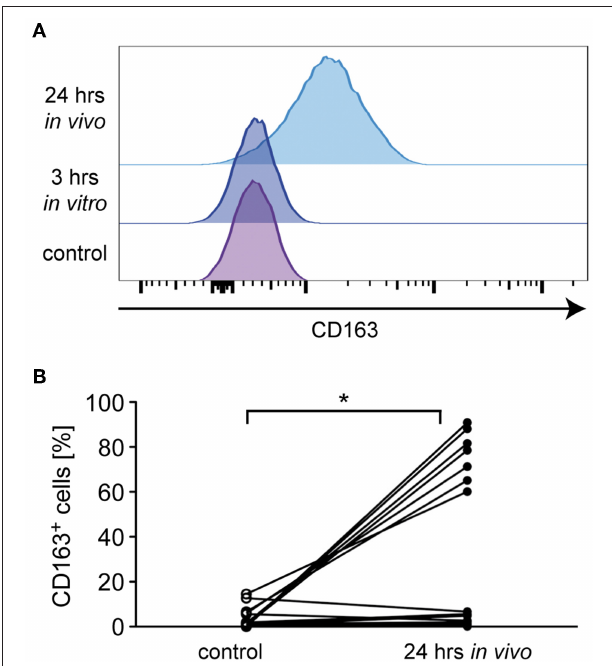
FIGURE 5 | Analysis of monocyte CD163 surface levels in MS patients. Monocytes were isolated from MS patients before MP pulse therapy and cultured without (control) or with 10 − 6 M MP for 3h in vitro . A second blood sample was obtained from the same MS patients 24h after MP pulse therapy in vivo . CD163 surface expression was analyzed by flow cytometry on all cells independently of the CD14/CD16 status. (A) Representative stacked histograms are depicted for an MS patient in which CD163 surface levels were upregulated after MP pulse therapy. (B) Percentages of CD163 + monocytes before (control) and 24h after MP pulse therapy in vivo . The corresponding values for each patient are connected by a line. n = 15. Statistical analysis was performed using a Mann Whitney test. Levels of significance: * p <